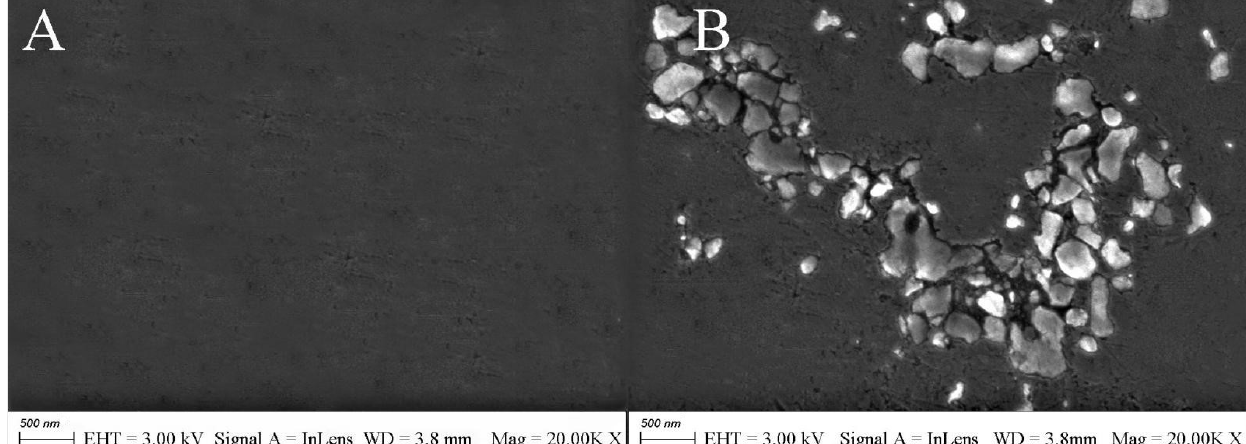
Figure 4. SEM micrographs of ( A ) bare Au and ( B ) Au/APTES